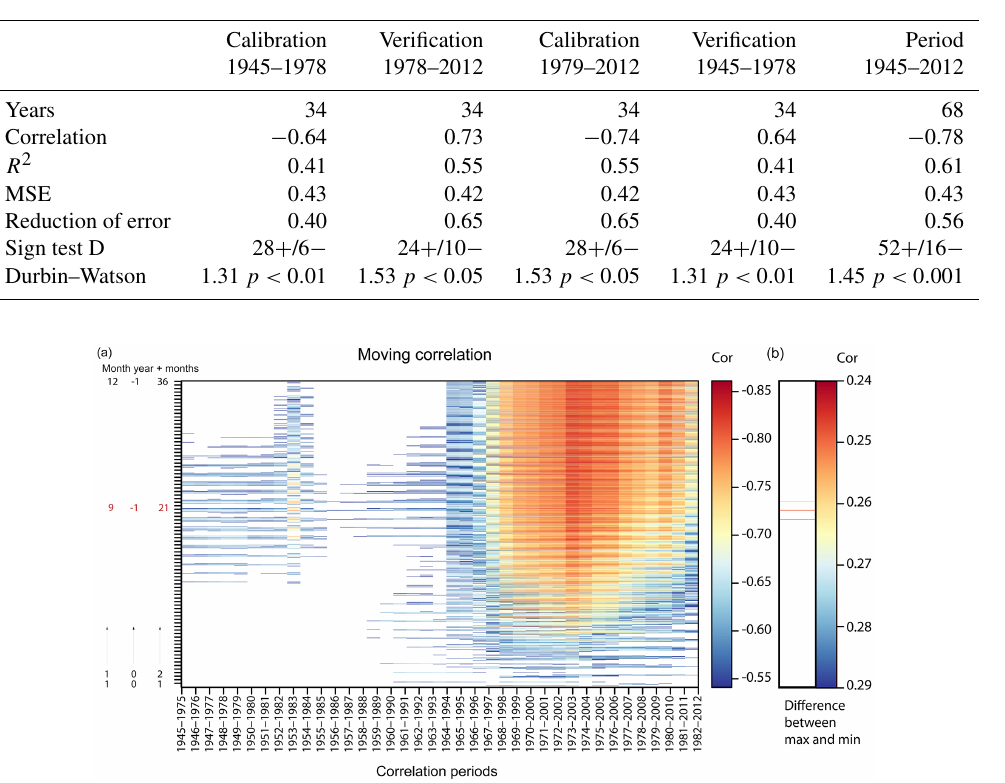
Table 2. Calibration/verification statistics of the IR2Tmax reconstruction.